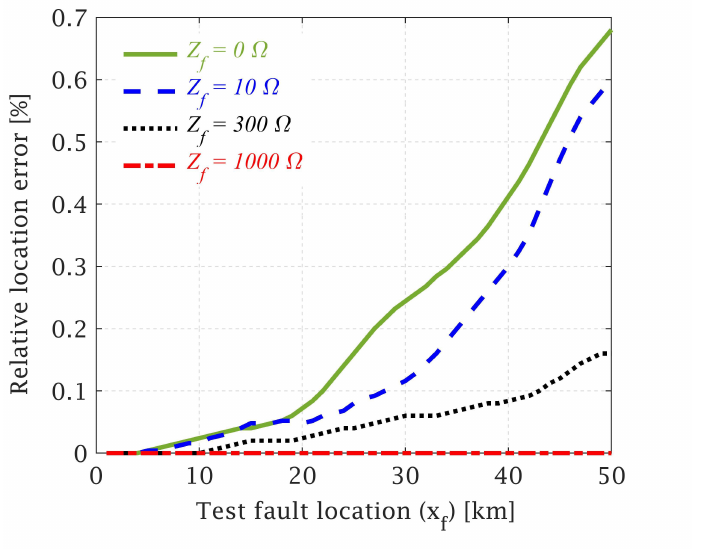
Figure 11. Impact of the fault impedance mismatch along the line length in terms of the relative location error; in the fault occurrence stage, four different values of fault impedance are considered, while in the fault estimation stage, Z f = 1000 Ω